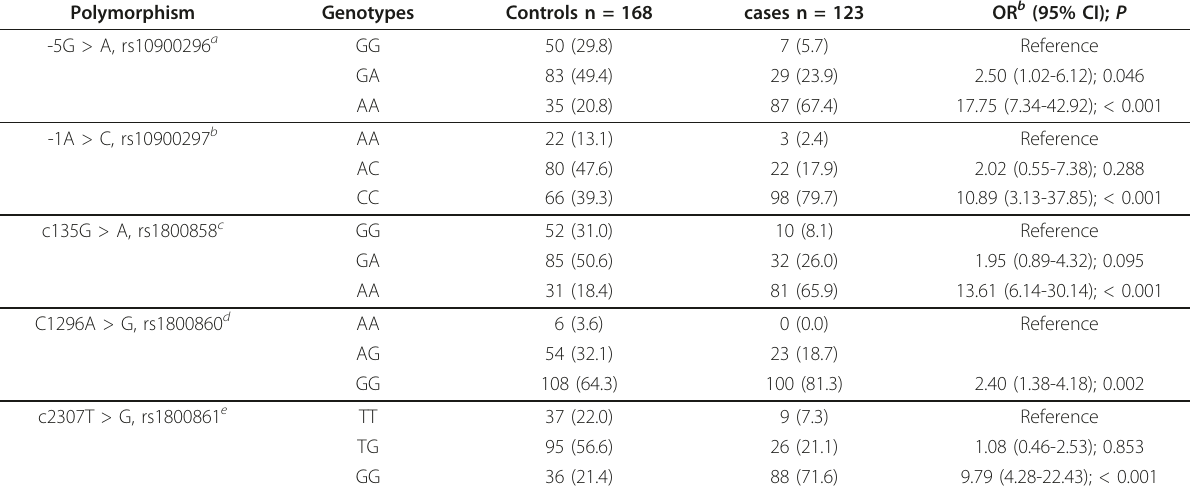
Table 1 Genotype distribution of the RET gene polymorphisms in case-control